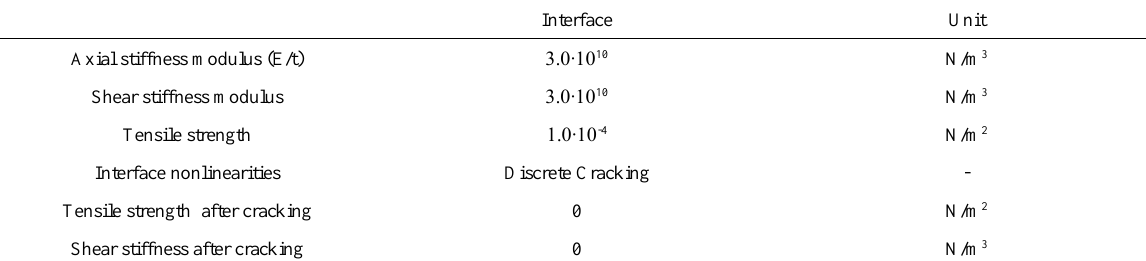
Table 2: Properties